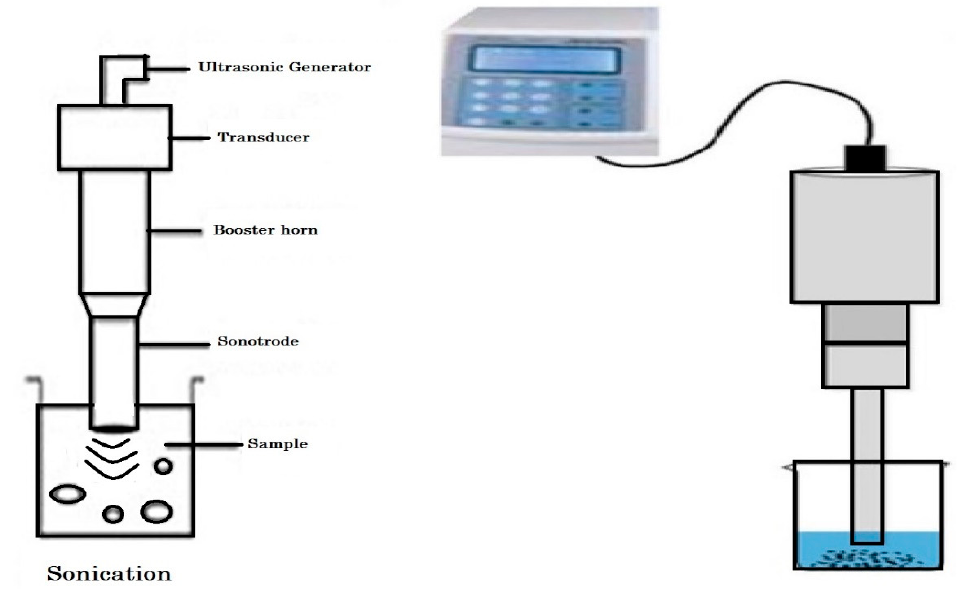
Figure 1. Schematic diagram of Sonicator.